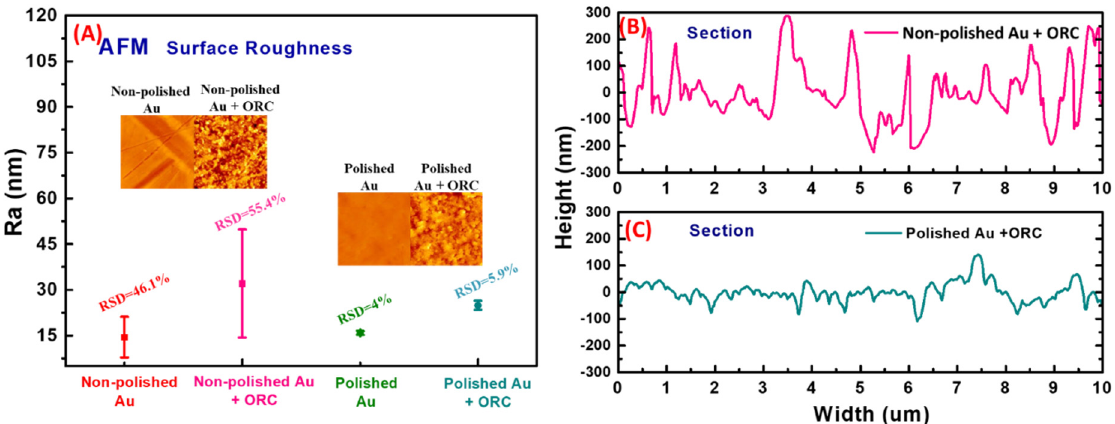
Figure 3. ( A ) Surface roughness profiles from AFM analysis of the Au substrate having undergone different treatments, and the height profile of ( B ) non-polished and ( C ) polished Au surface after ORC treatment.